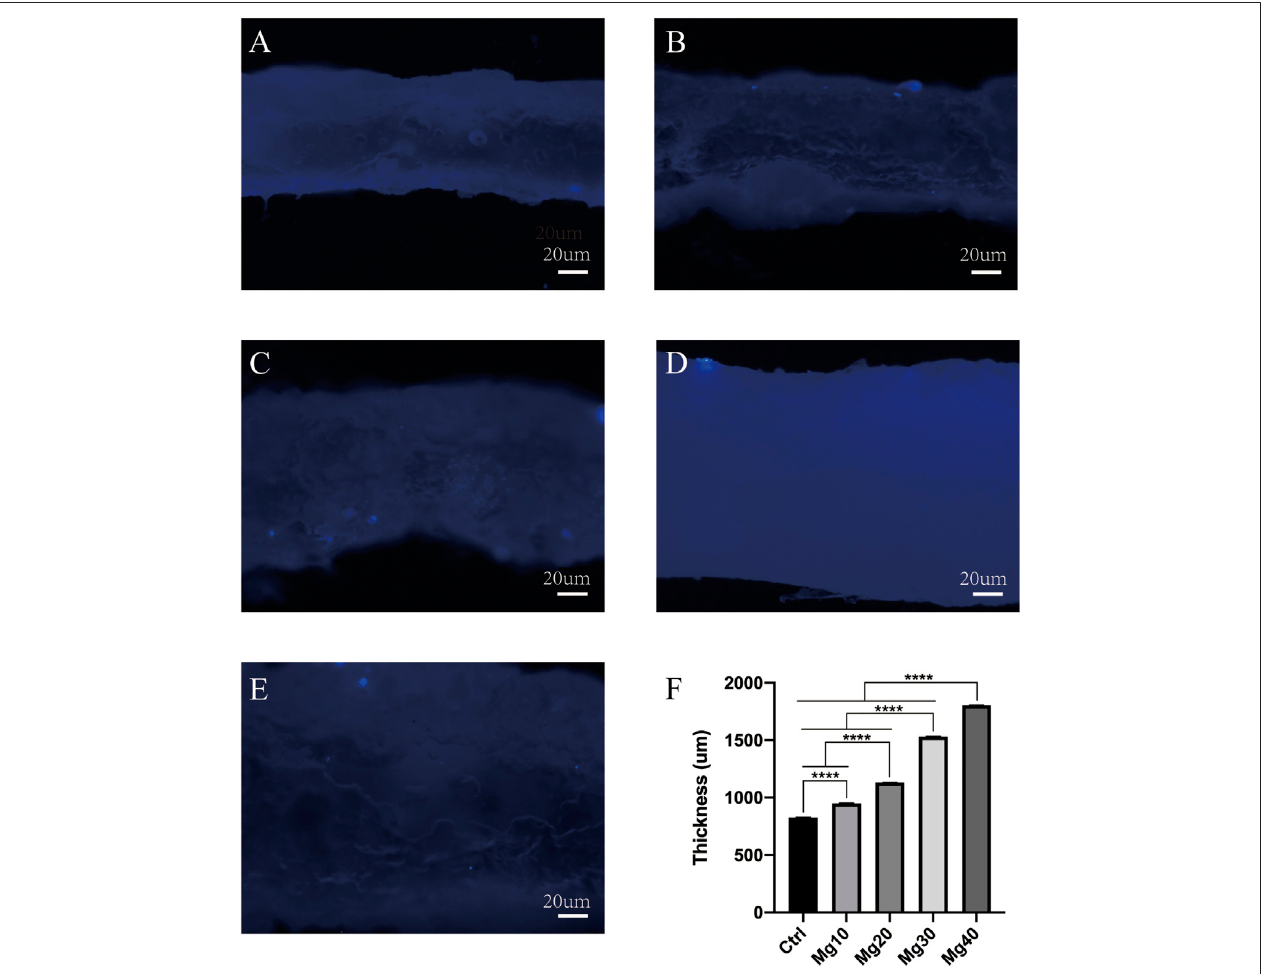
FIGURE 6 | The water absorption of different groups (Ctrl, Mg10, Mg20, Mg30, Mg40) of MgSO 4 /MgO/SA/Na-CMC composite hydrogels under fl uorescence microscope (A – E) . P ≤ 0.0001 was considered statistically signi fi cant (****).